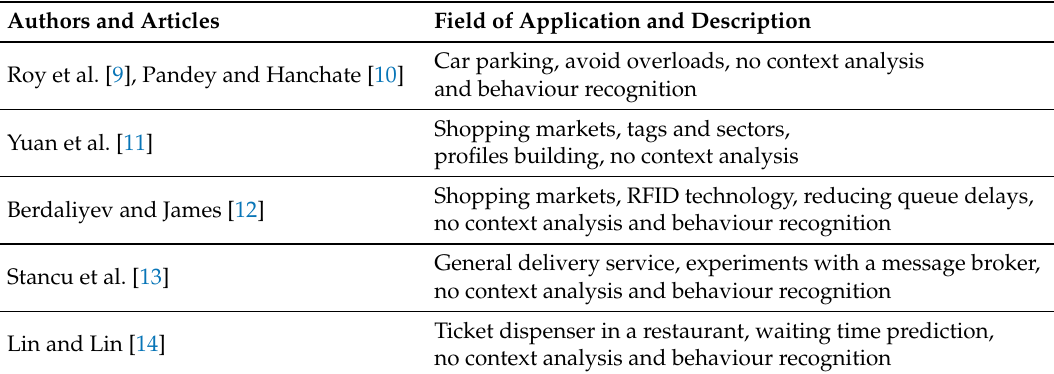
Table 1. Comparision for existing studies and